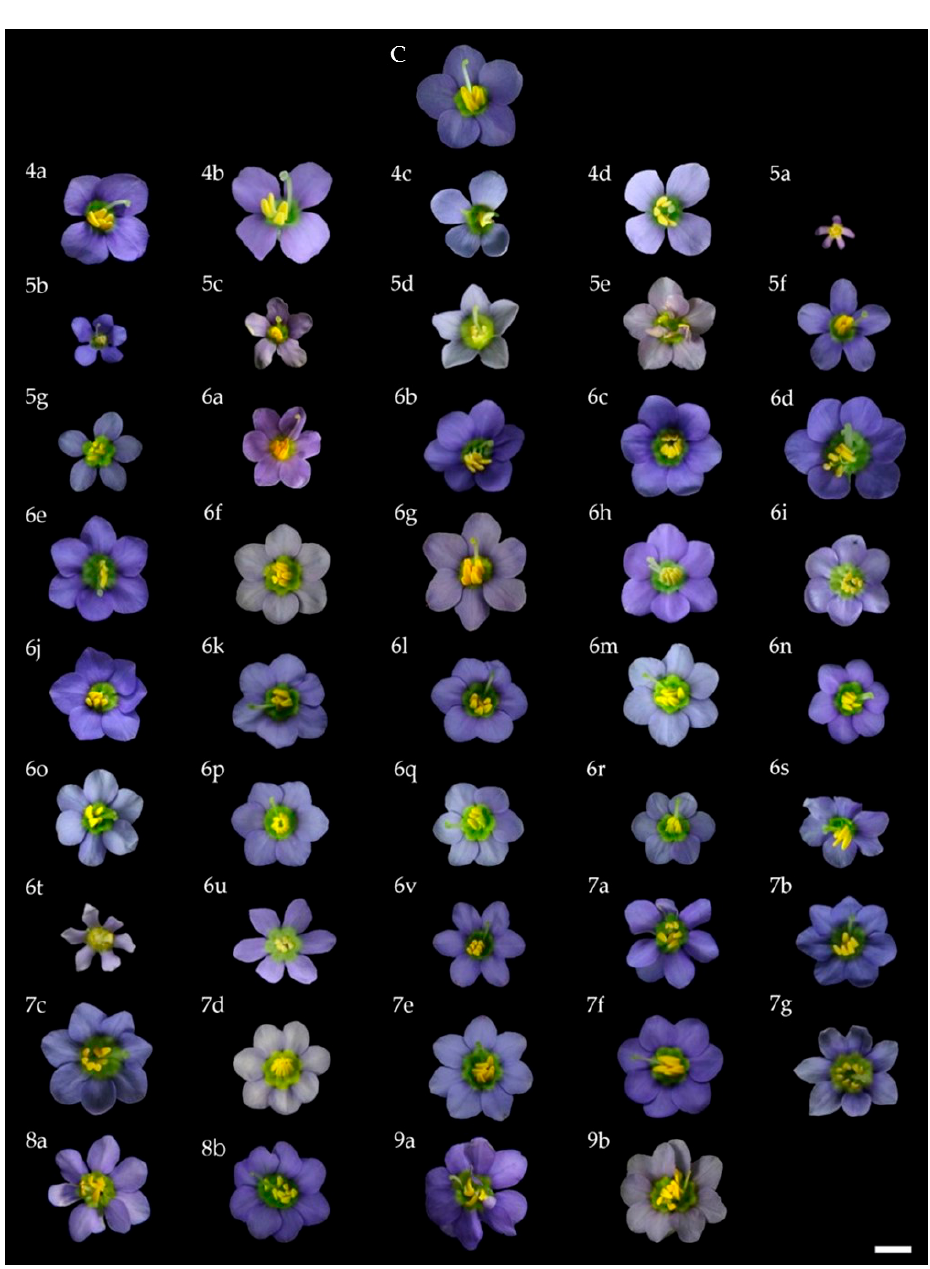
0.8 ± 0.7 cm, 5 petals with violet-blue group color (93-B), five anthers with yellow-orange group color (14-A), and an emerging style approximately 4 mm long. After UV-C